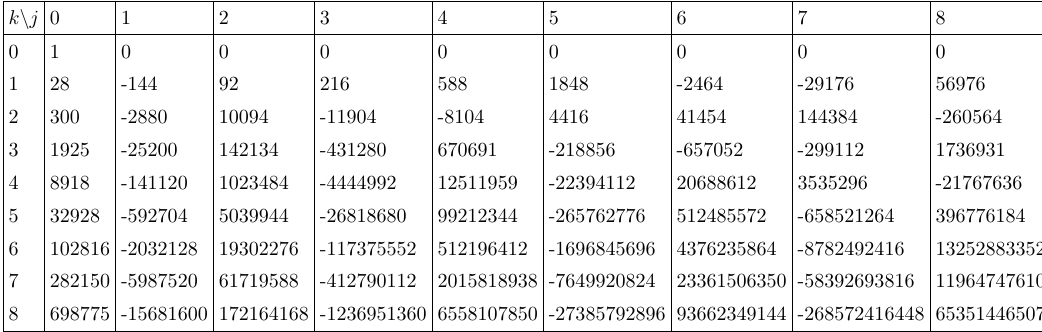
Table 43. Table of b jk coe(cid:14)cients for h SO(8)